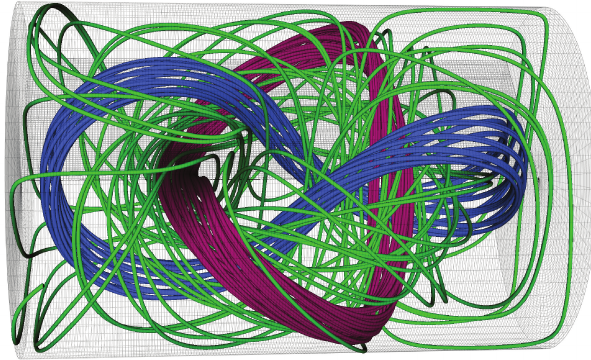
Fig. 5. Three magnetic field lines of the saturated minimum mag- netic energy n = 1 helical state (Cothran et al., 2010) from the single-fluid HiFi computation with p | t = 0 = 1 p 0 and ν = 5 × 10 − 6 in the L : r 0 = 3 : 1 computational domain used in this